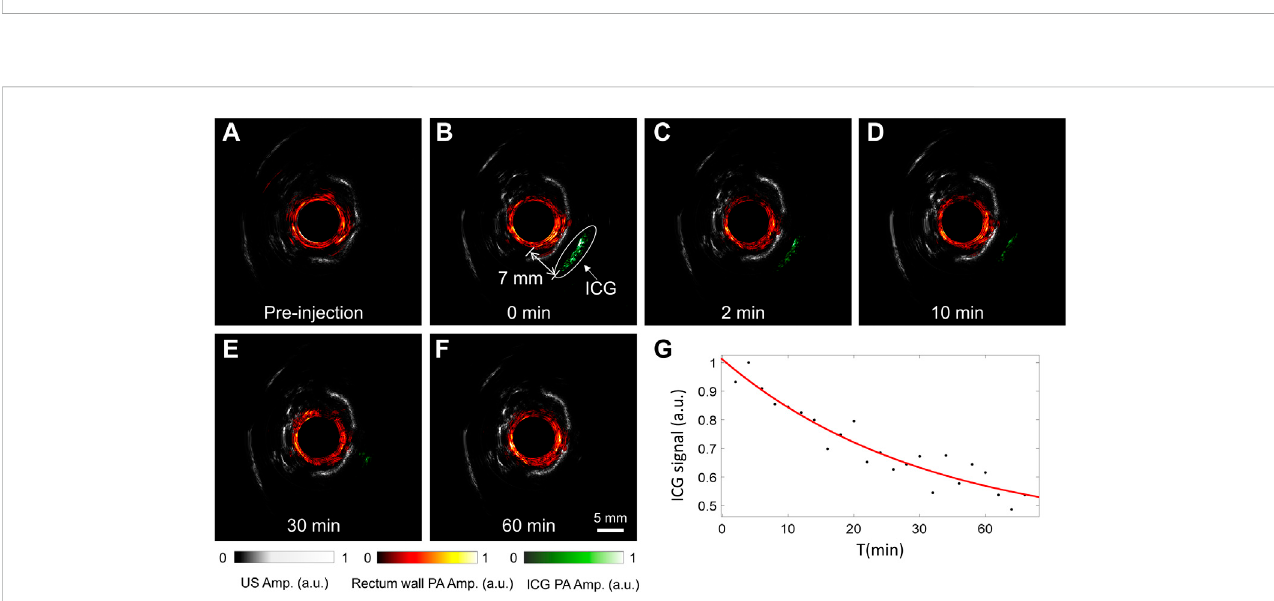
FIGURE 3 Experimental results for tracking the injected ICG near the rabbit rectum. (A – F) Comparison of photoacoustic and ultrasound images of the rabbit rectum before (A) andafter (B – F) ICGinjection, withtheimageacquisitiontime indicated. (G) ThechangeofthepeakICGsignalwith time.The druginjection time was set to